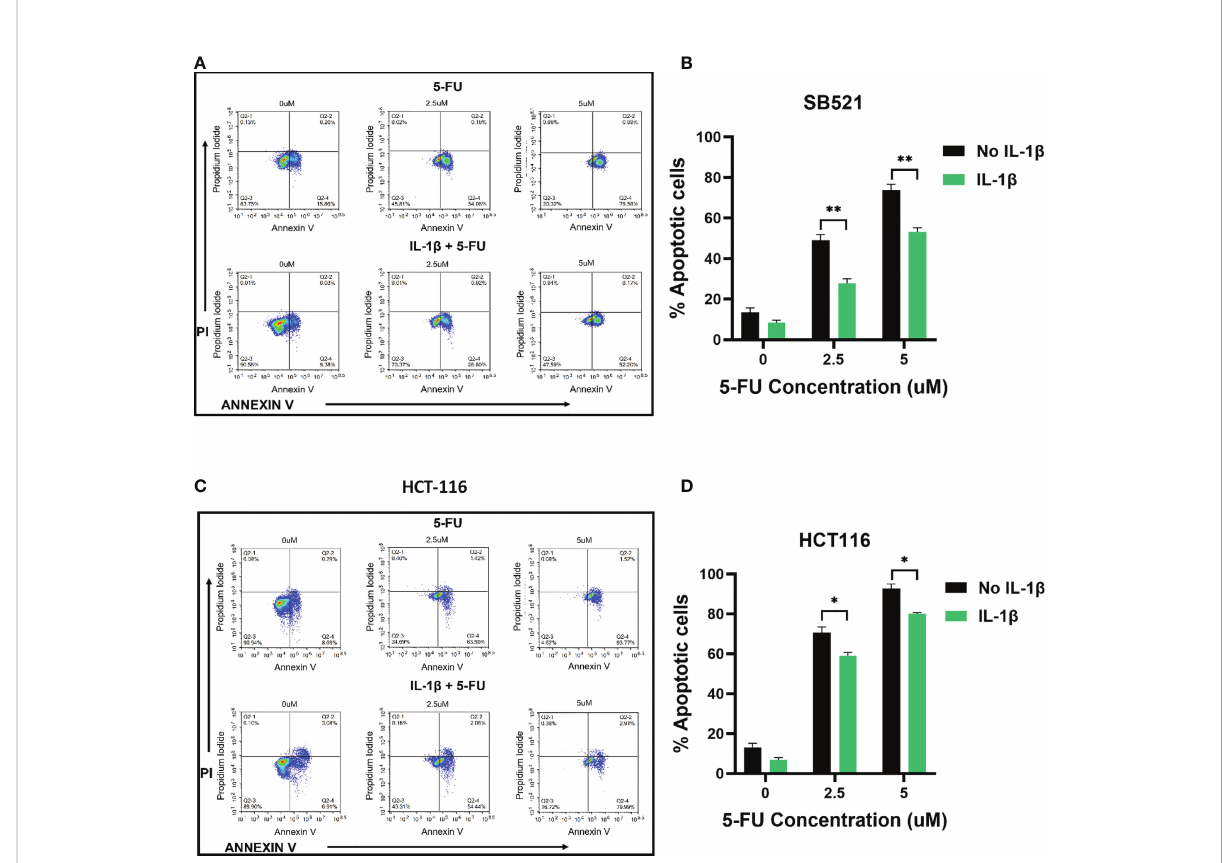
FIGURE 5 IL-1 b decreases 5-FU-induced apoptosis in MSI cell lines. Apoptosis detection by Annexin V/PI staining via fl ow cytometry following treatment with different concentrations of 5-FU (0, 2.5, 5 mM), in the presence or absence of IL-1 b . Representative images of fl ow cytometry data for SB- 521 (A) and HCT 116 (C) ; Percentage of combined early apoptotic (Annexin V+) and late apoptotic (Annexin V+/PI +) cells for SB-521 (B) and HCT 116 (D) cell lines. Data are representative of three independent experiments. Error bars represent SEM. *p<0.05,